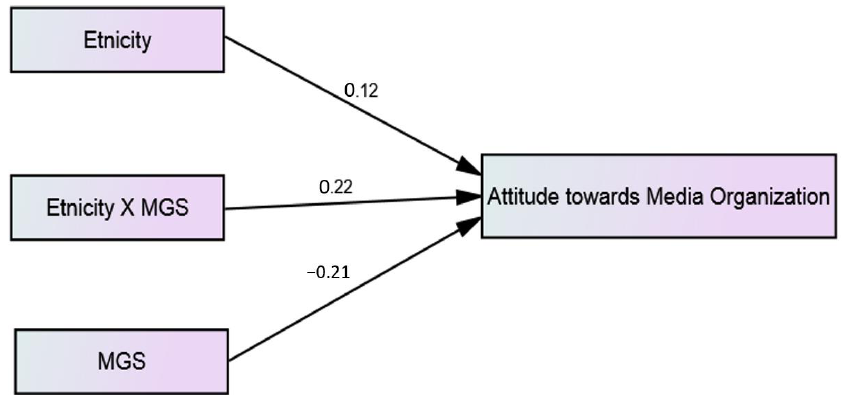
Figure 3. Structural model with Moderation of Ethnicity in MGS and AO link.